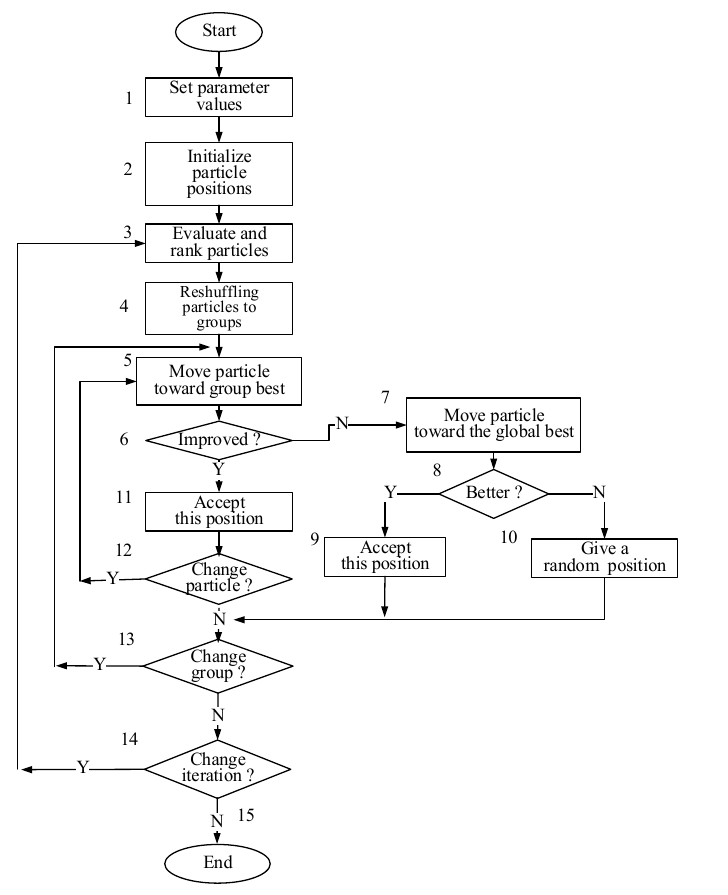
Figure 8. The basic logic flow of the MGPSO. The function INT ( • ) rounds a real value to its nearest integer. The P is total number of particles. The T is total number of iterations. At the first iteration, t = 1, a minimum momentum is created to explore the solution space. At the last iteration, t = T, a maximum momentum is created to exploit the best elite of each group. Finally, Feature (4) enables an adaptive fly for a particle based on its current position relative to the position of a target particle (which can be the best particle of the same group or the global best particle in the swarm). Equation (34) is the adaptive velocity used by the MGPSO, which is an improvement of Equation (31) of PSO, in which the random numbers R1 and R2 tend to make random